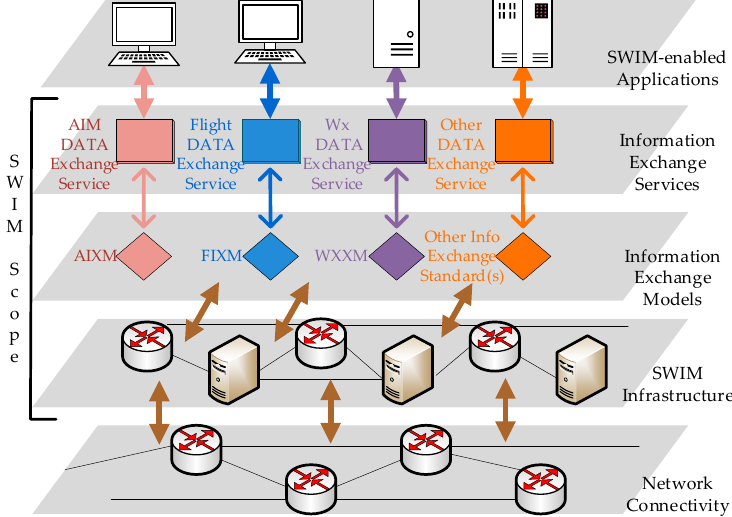
Figure 1. The global interoperability network architecture.